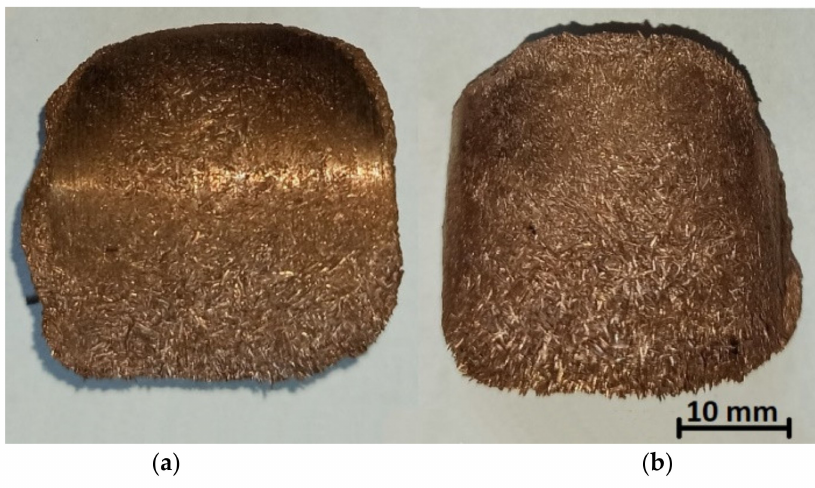
Figure 1. Briquettes used for testing: ( a ) back, ( b ) front.